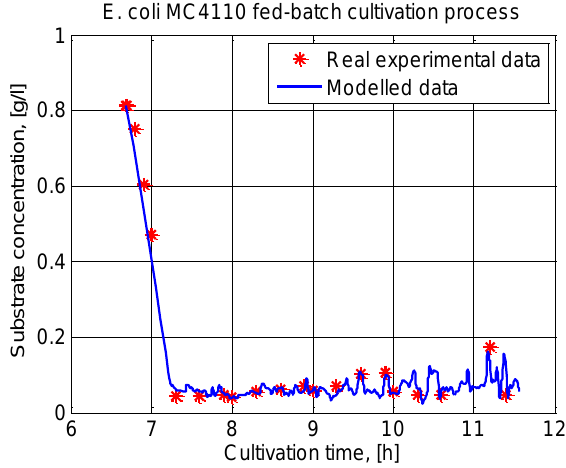
Figure 4. Time profiles of the process variable substrate: real experimental data and model predicted data.